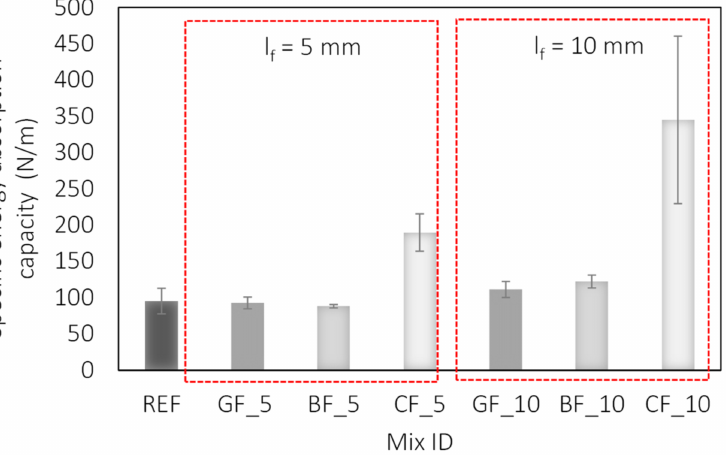
Figure 6. Influence of fibre type and length on specific energy absorption capacity of fibre- reinforced